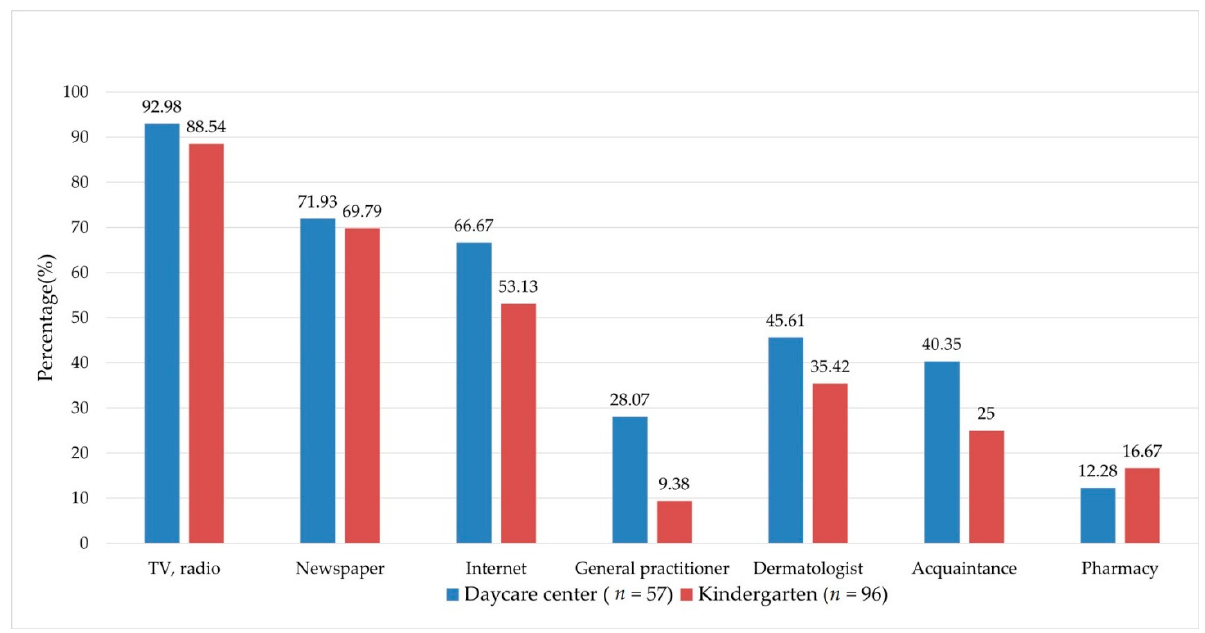
Figure 1. Information sources among caregivers concerning sun